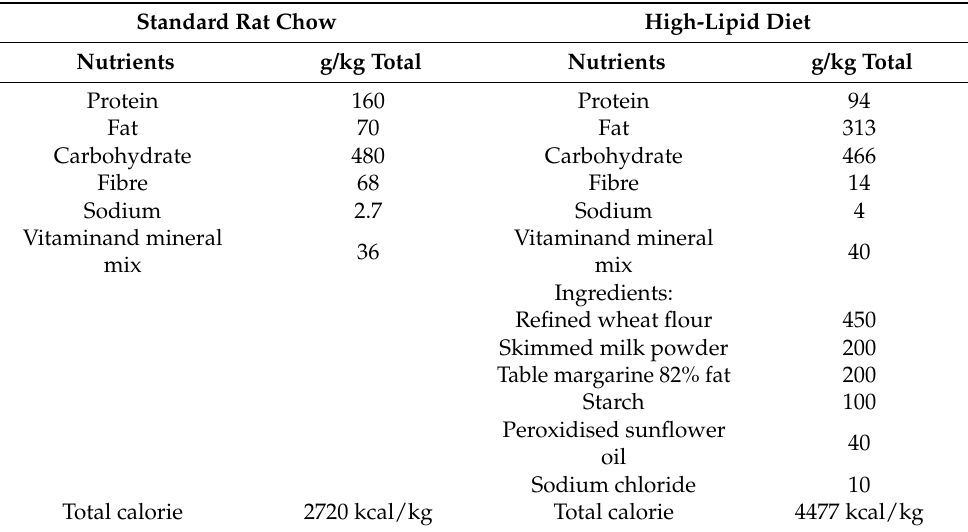
Table 1. Components and contents in standard and high-lipid